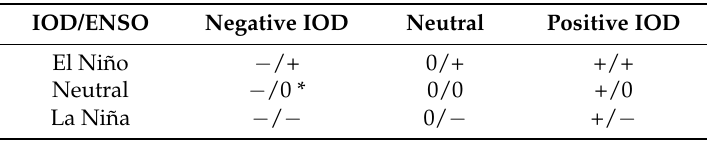
Table 1. Classification of years when El Niño or La Niña and/or positive or negative Indian Ocean dipole occurred.